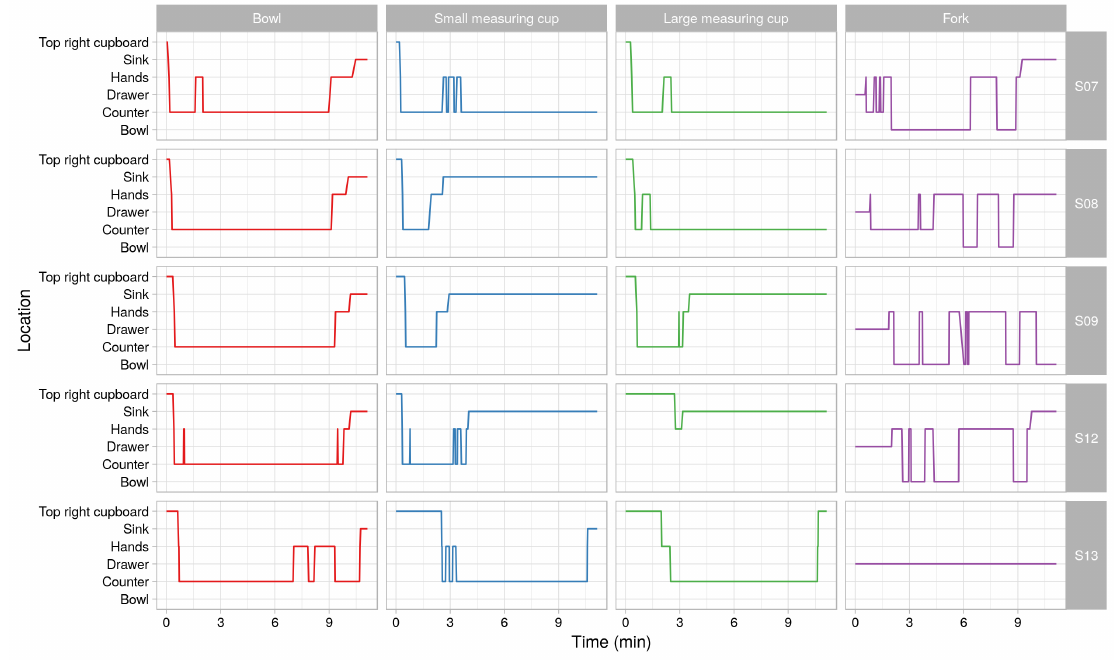
Figure 11. The location of different objects over time for different